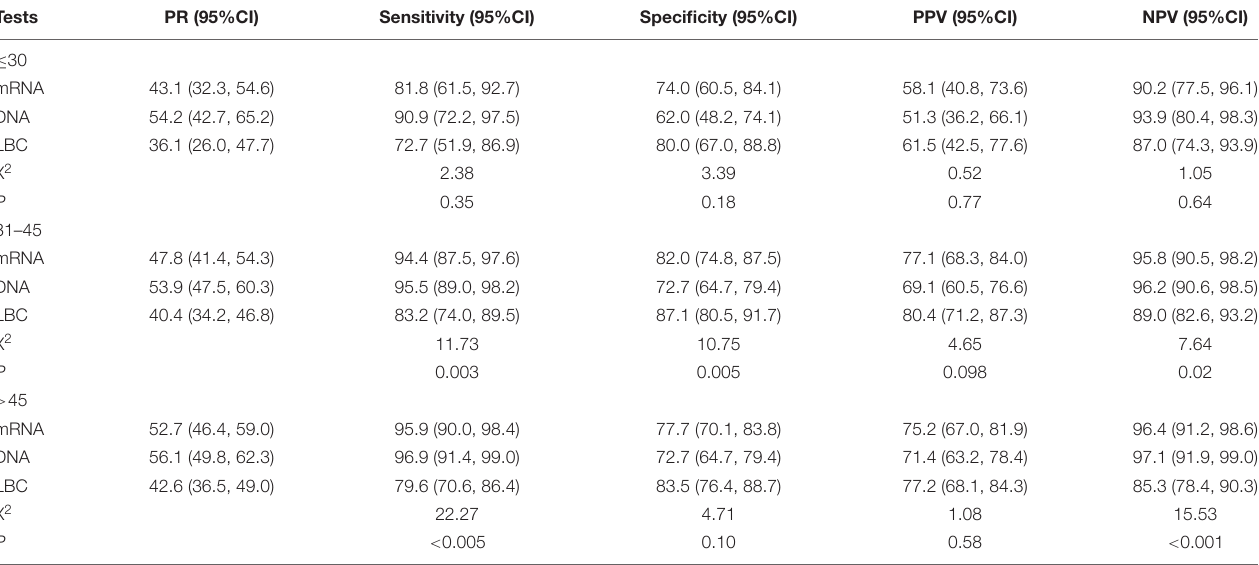
TABLE 4 | The positive rates and clinical performance of tests to detect CIN2 + in different age groups.